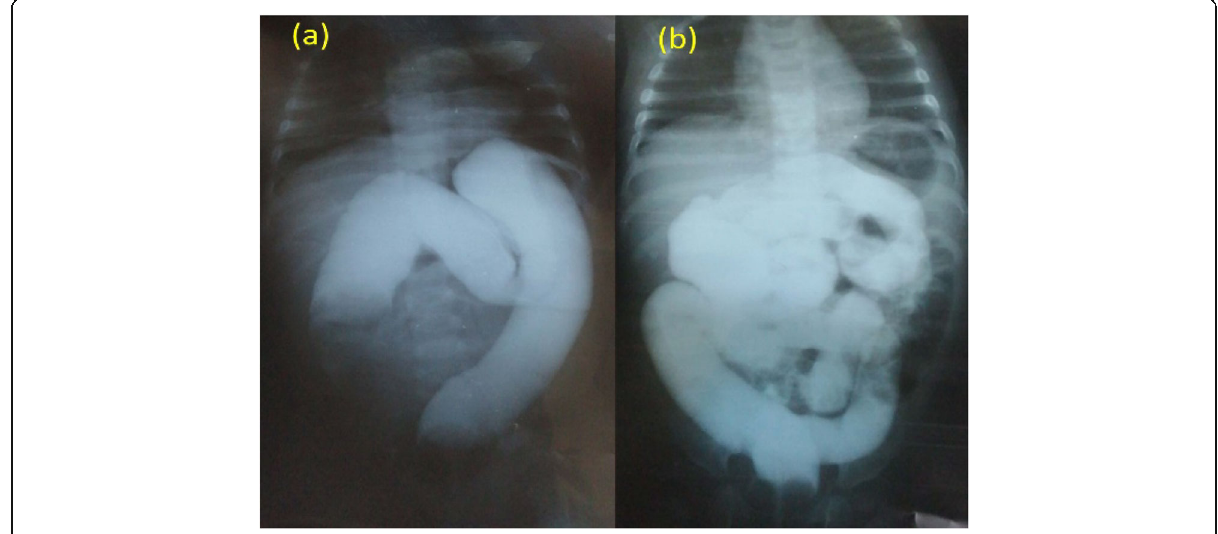
Fig. 1 Contrast study of abdomen (contrast enema). a Partial reduction of intussusception. b Complete reduction of